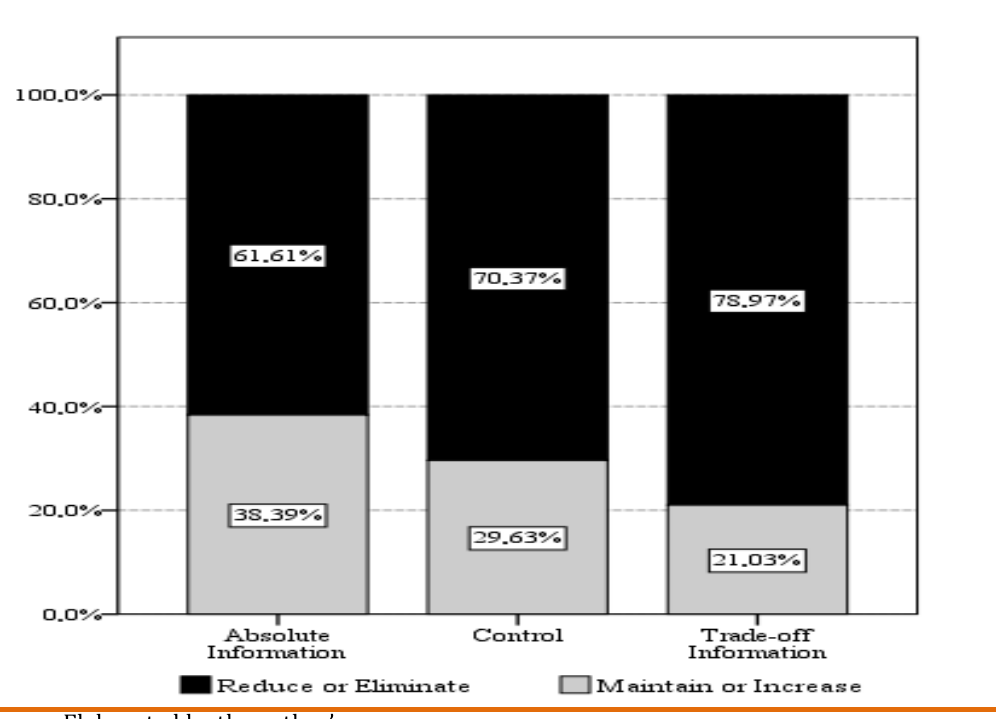
Figure 01. Difference between control and treatment groups